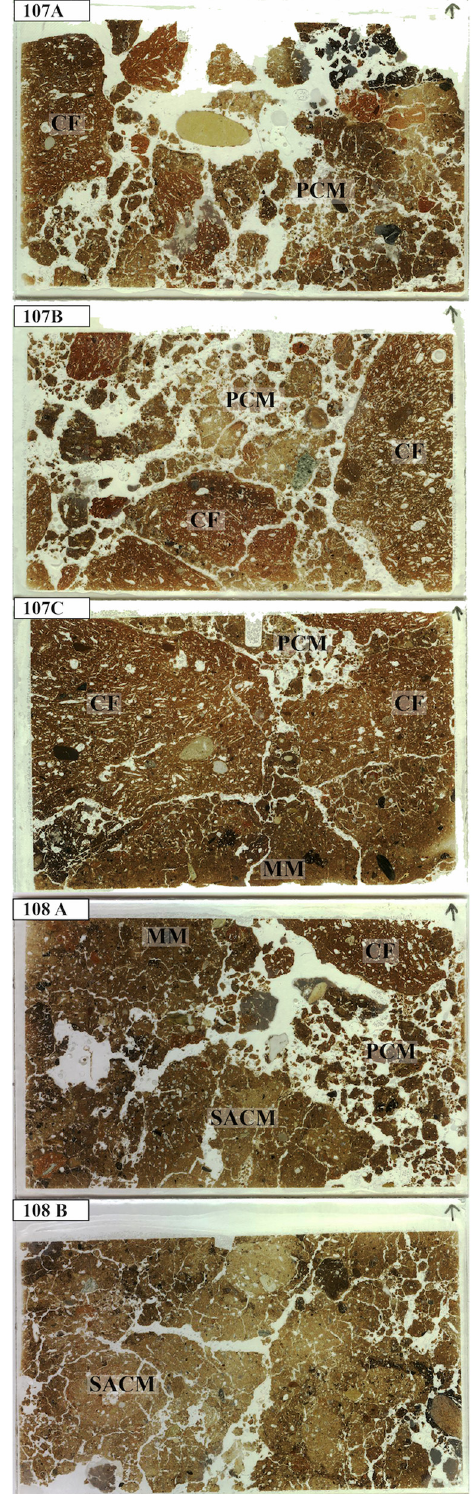
Figure 9: Thin sections aligned to their elevation in the fi ll. ( Note, in actual fi ll sample 108 is approximately 20 cm to the right of sample 107, see Figure 8 ) . Each thin section is 9 cm long and 6 cm wide. The lowest thin section ( 108B ) is composed of a somewhat accommodating crumbly microstructure ( SACM ) , this microstructure with no ceramic fragments is composed of a well - formed groundmass divided into somewhat accommodating pedological structures. In the next thin section ( 108A ) , the SACM transitions into porous crumbly microstructure ( PCM ) with the introduction of the gravel - sized ceramic fragments ( CF ) . To the top and left of this thin section, the SACM also transitions into a more massive microstructure ( MM ) . The MM is continued in the next thin section ( 107C ) where it transitions into a PCM with the introduction of further gravel - sized CF. A pattern that continues in the next two thin sections ( 107B and 107A ) . Prepared by Ada